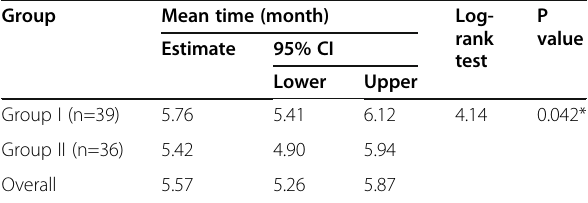
Table 4 Median time of recurrence of spontaneous bacterial peritonitis between both studied